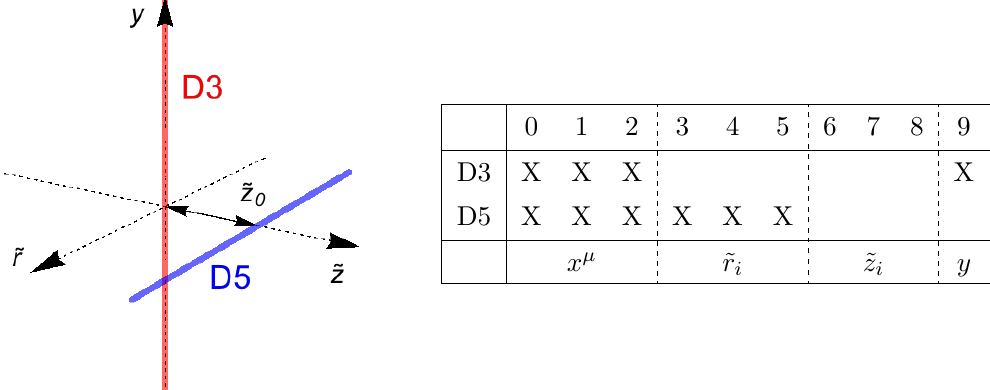
Figure 1 . The intersecting brane system. The x (cid:22) directions common to both types of brane worldvolume are suppressed in the (cid:12)gure on the left. The D5-branes can be separated from the D3-branes by a distance ~ z 0 in the directions transverse to both